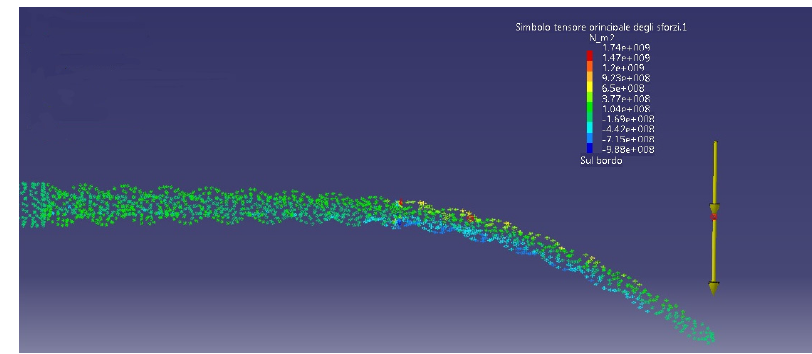
Figure 24: FEM simulation with the Tip applied load.